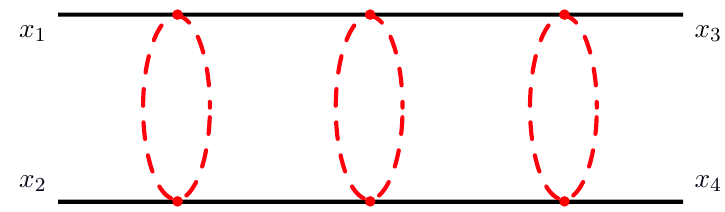
Figure 2 . An example of zero-magnon u -channel fishnet ladder diagram evaluated in the compu- tation of G u ( z, z ) . The dashed/solid four-point interaction sites have coupling ξ 2 so this diagram contributes at order ξ 12 . The only other diagrams are of this form but with any number of